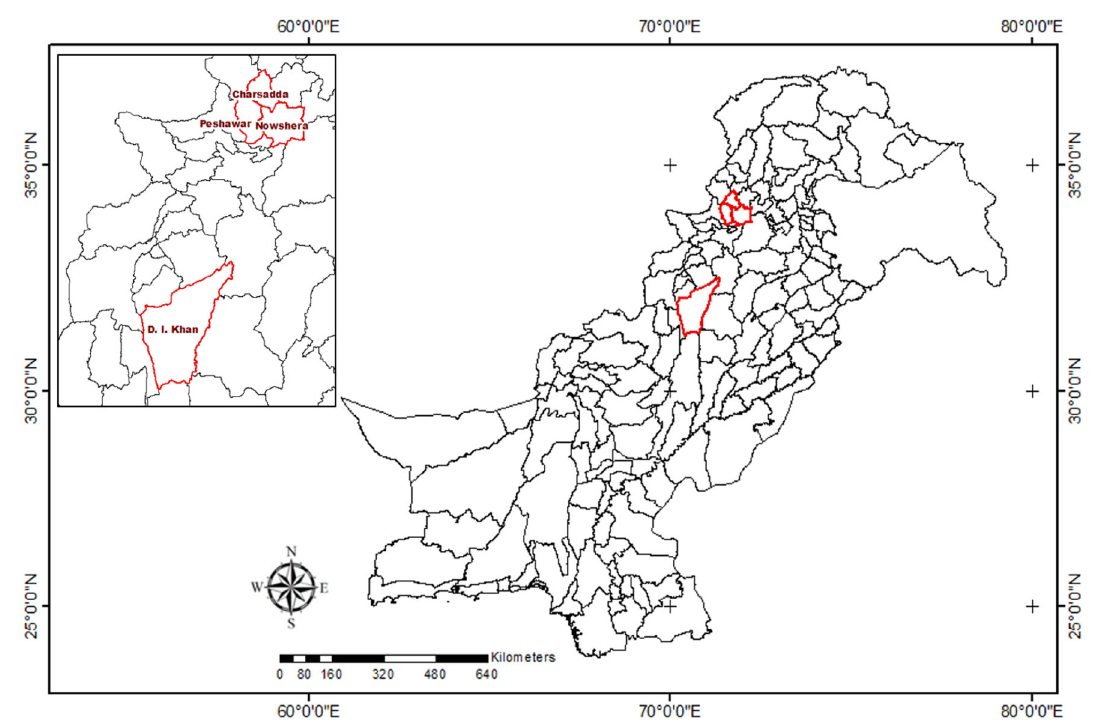
Fig. 1 Sample study districts in Khyber Pakhtunkhwa Province,